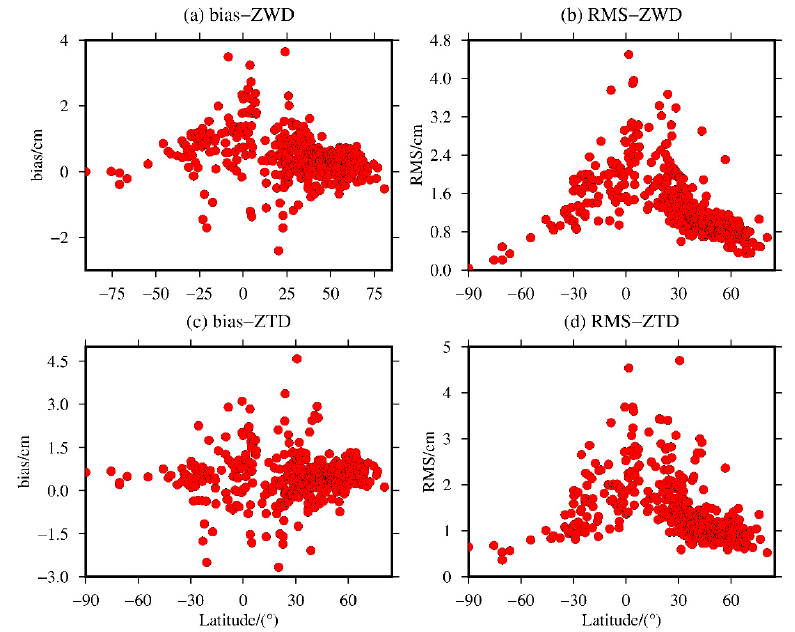
Figure 16. The ( a , c ) bias and ( b , d ) RMS values of the ZWD and ZTD values from the MERRA-2 data with respect to latitude